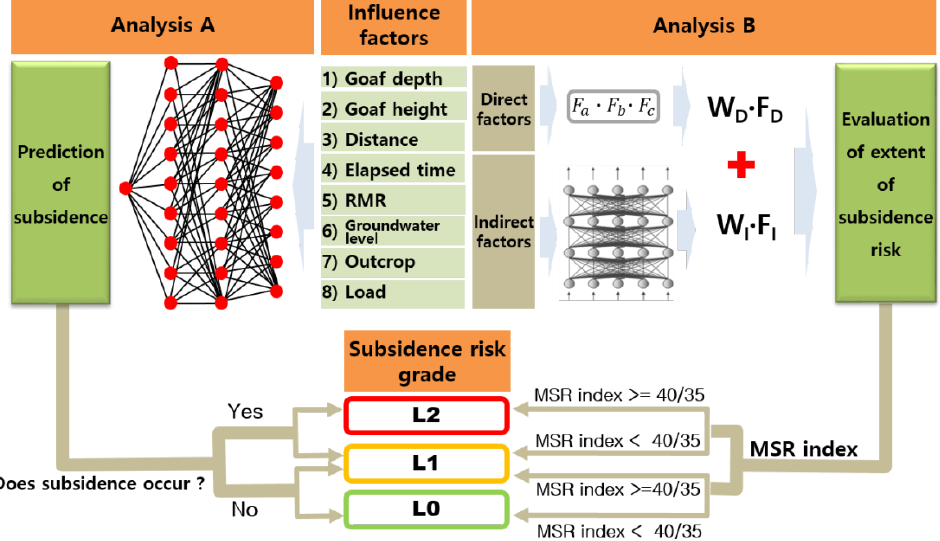
Figure 18. Summary of the subsidence risk grade analysis procedure.